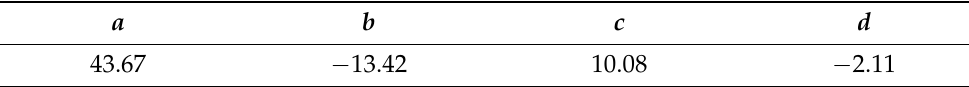
Figure 4. Mapping relationship: ( a ) the relative density and the average aspect ratio; ( b ) the relative density and the postprocessing equivalent heat conductivity. Table 2. The fitting parameters a , b , c , and d in Equation